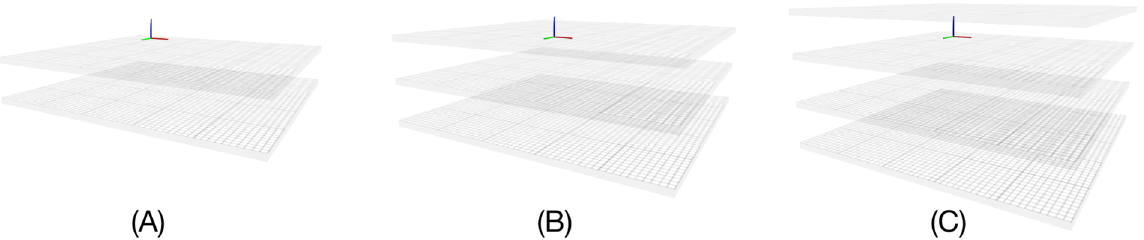
Figure 2. Representation of the double membrane under UnityMol. Combination of 4 cubic primitives structured in the form of a lattice whose transparency A varies for the “inner layers”, i.e., for the interfaces that merge from A = 0: completely transparent to A = 255: completely opaque ( A ) for m = 0 ≡ A = 0, ( B ) for m ≃ 15.75 ≡ A ≃ 255/2, ( C ) for m ≃ 30 ≡ A = 255.